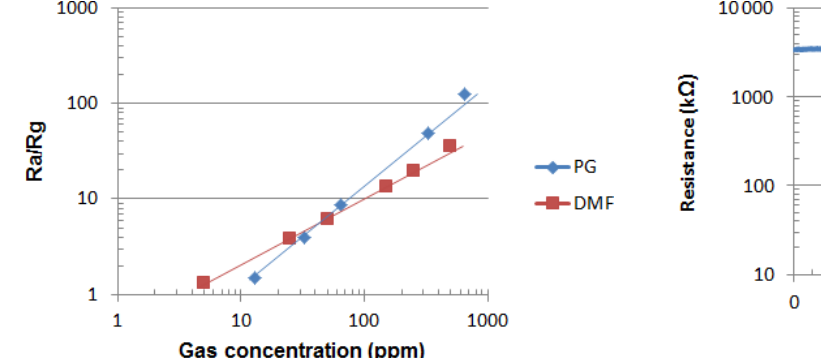
Figure 9. The electrical resistance change in MWCNTs/SnO 2 thick-film PG sensors vs. time measured upon cyclic exposure of 650ppm PG vapors in air at 200 ◦ C operating temperature.